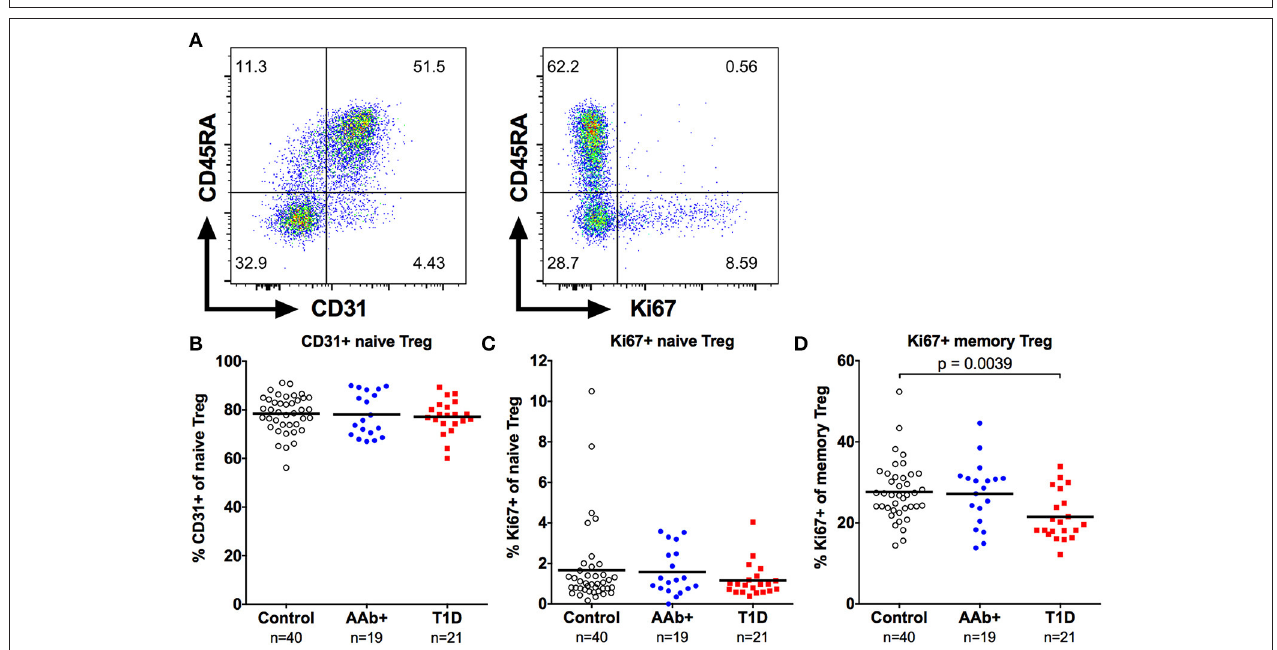
FIGURE 5 | Decreased frequency of proliferating memory Tregs in children with newly diagnosed T1D. Representative examples of CD31 ( A , left) and Ki67 ( A , right) expression on CD4 + CD25 + CD127lowFOXP3 + Tregs. Frequencies of CD31 + naive Tregs (B) , and Ki67 + naive (C) and memory (D) Tregs in control, AAb + and T1D